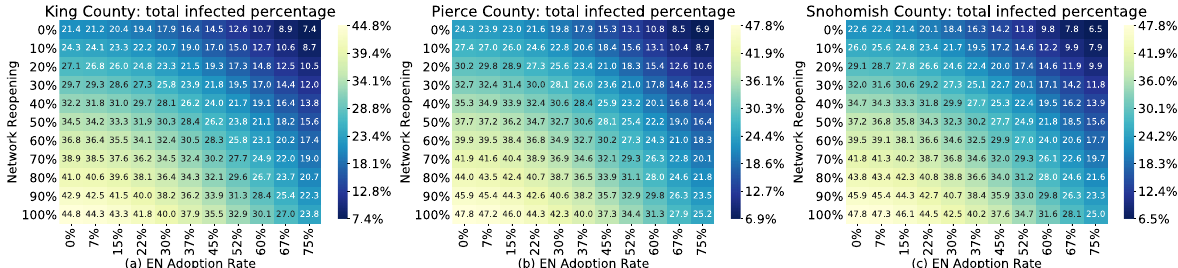
Fig. 6 Simulated reopenings under varied exposure noti fi cation adoption rates. Estimated total infected percentage as of December 25, 2020 as a function of simultaneous network reopening and exposure noti fi cation app adoption rates, assuming fully staffed manual contact tracing (15 workers per 100,000 people), in King ( a ), Pierce ( b ), and Snohomish ( c ) counties. The infectious rate increases due to a 10 – 20% reopening are balanced by decreases due to a 22 – 37% exposure noti fi cation app adoption, although the effect varies by county.